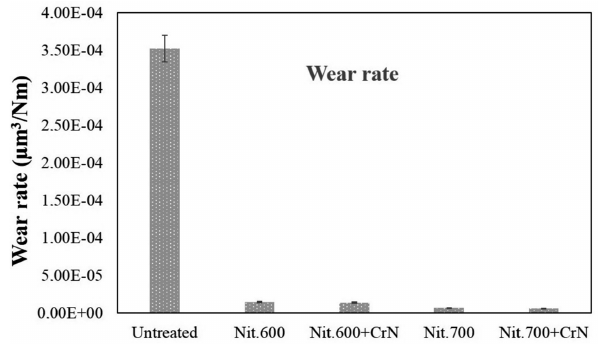
Figure 6: The graph of wear rate values of the untreated and treated pure titanium specimens.